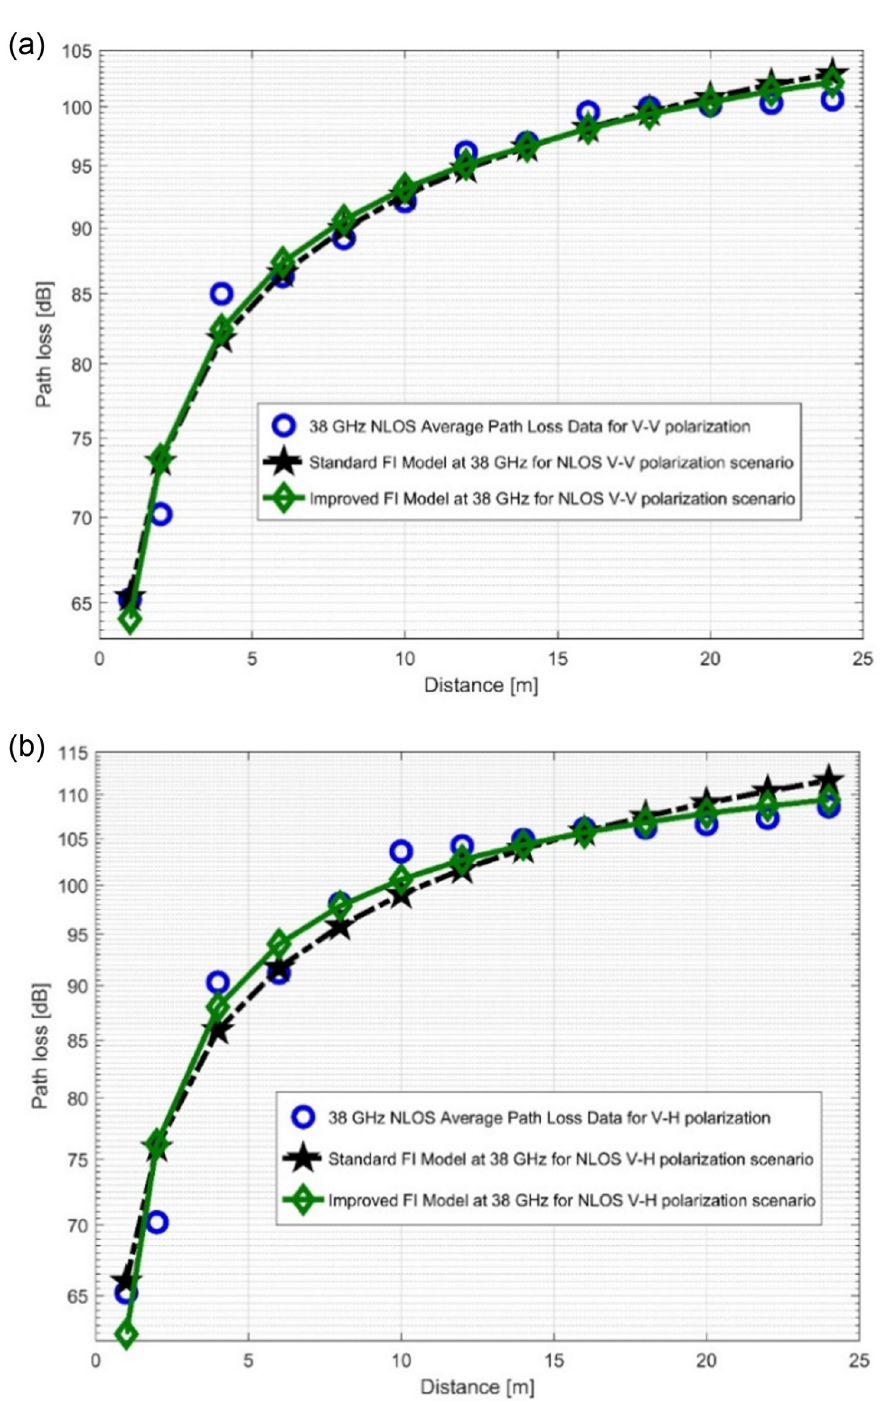
Fig 15. PL vs distance at 38 GHz for the NLOS scenario at (a) V-V polarization, (b) V-H polarization.